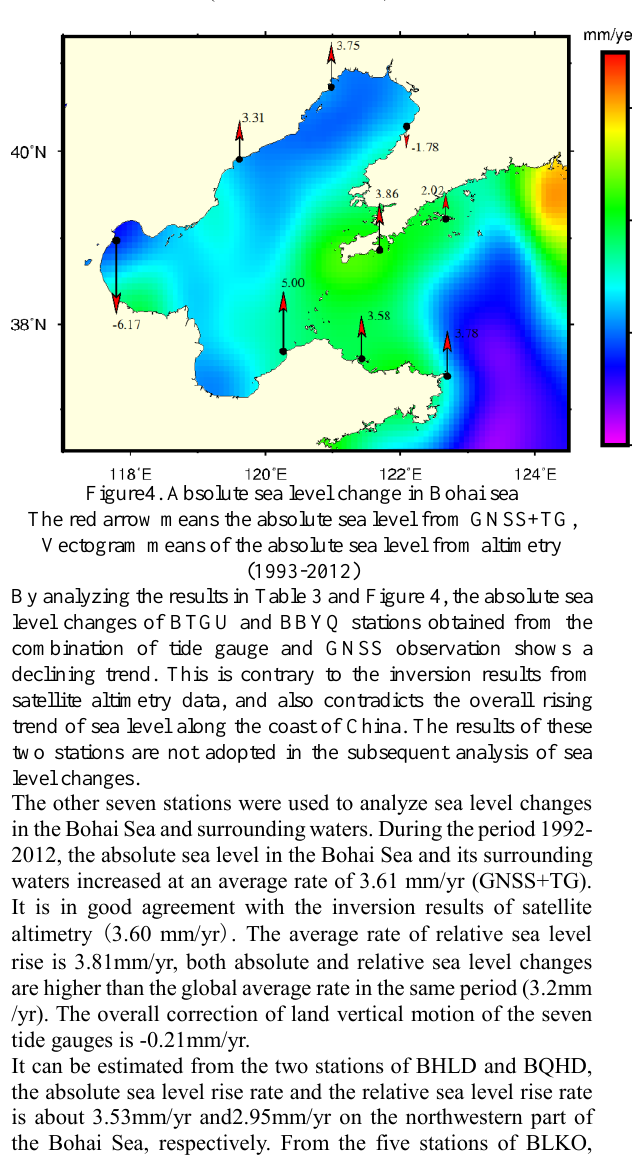
Table 3. Absolute sea level at nine sites (Unit: mm/yr) *Note: The relative sea level change rate is quoted from the paper “Vertical motions of tide gauge stations near the Bohai Sea and Yellow Sea” (Shouhua Liu et al., 2015).